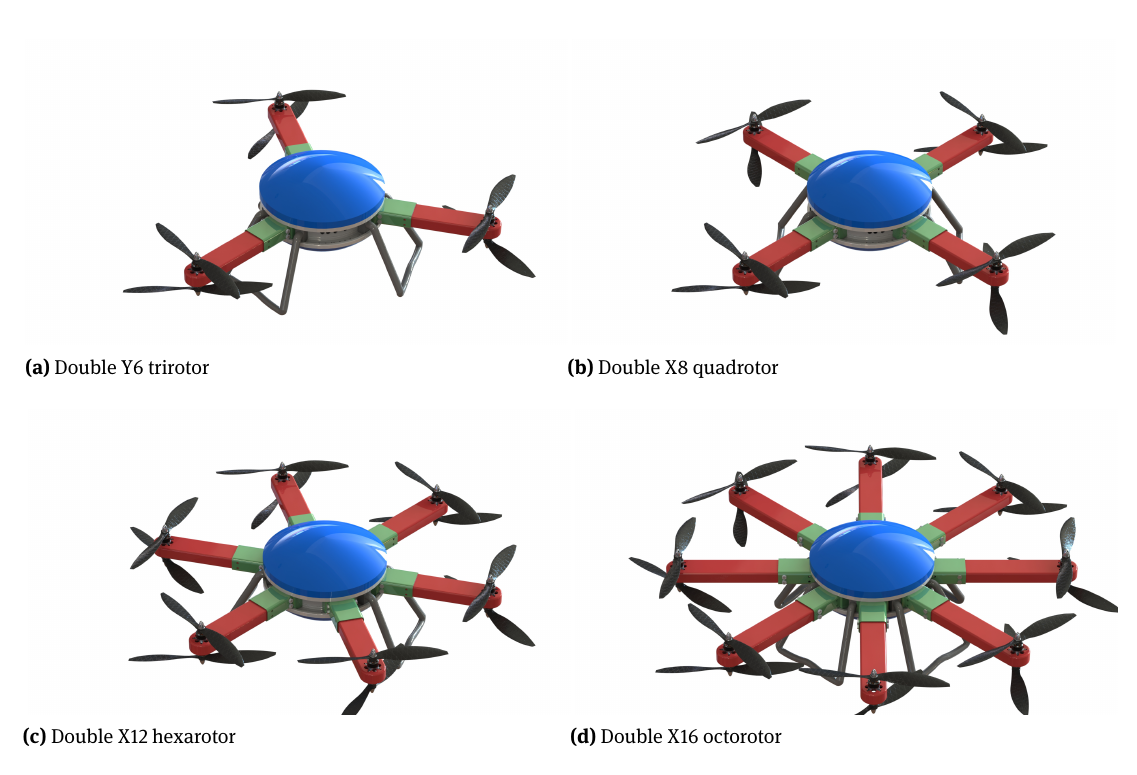
Figure 12: Multirotor configurations with double rotor for each